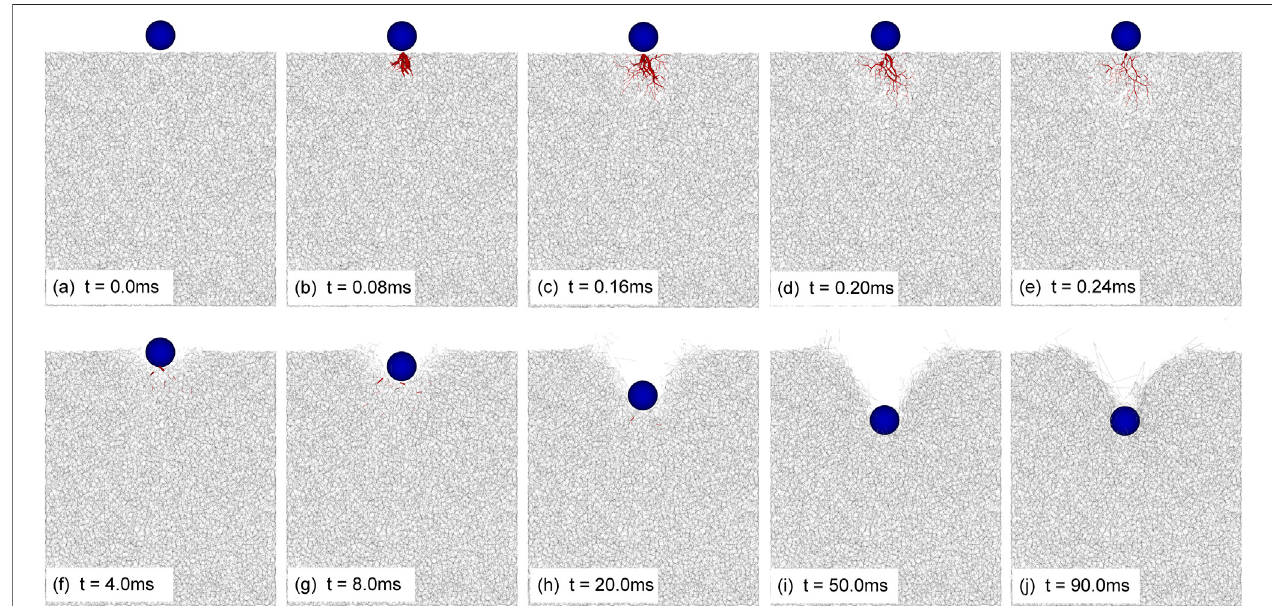
FIGURE 4 | Evolutions of contact force chains during the impact process ( v 0 = 5.0 m/s). The thickness of force chains is proportional to the force magnitude, and redifforceislargerthan0.6 N,otherwisegray.Notethatthethresholdvalue(0.6 N)isthelargestcontactforceatt=0.0 s. (A) t=0.0 ms, (B) t=0.08 ms, (C) t=0.16 ms, (D) t = 0.20 ms, (E) t = 0.24 ms, (F) t = 4.0 ms, (G) t = 8.0 ms, (H) t = 20.0 ms, (I) t = 50.0 ms. (J) t = 90.0